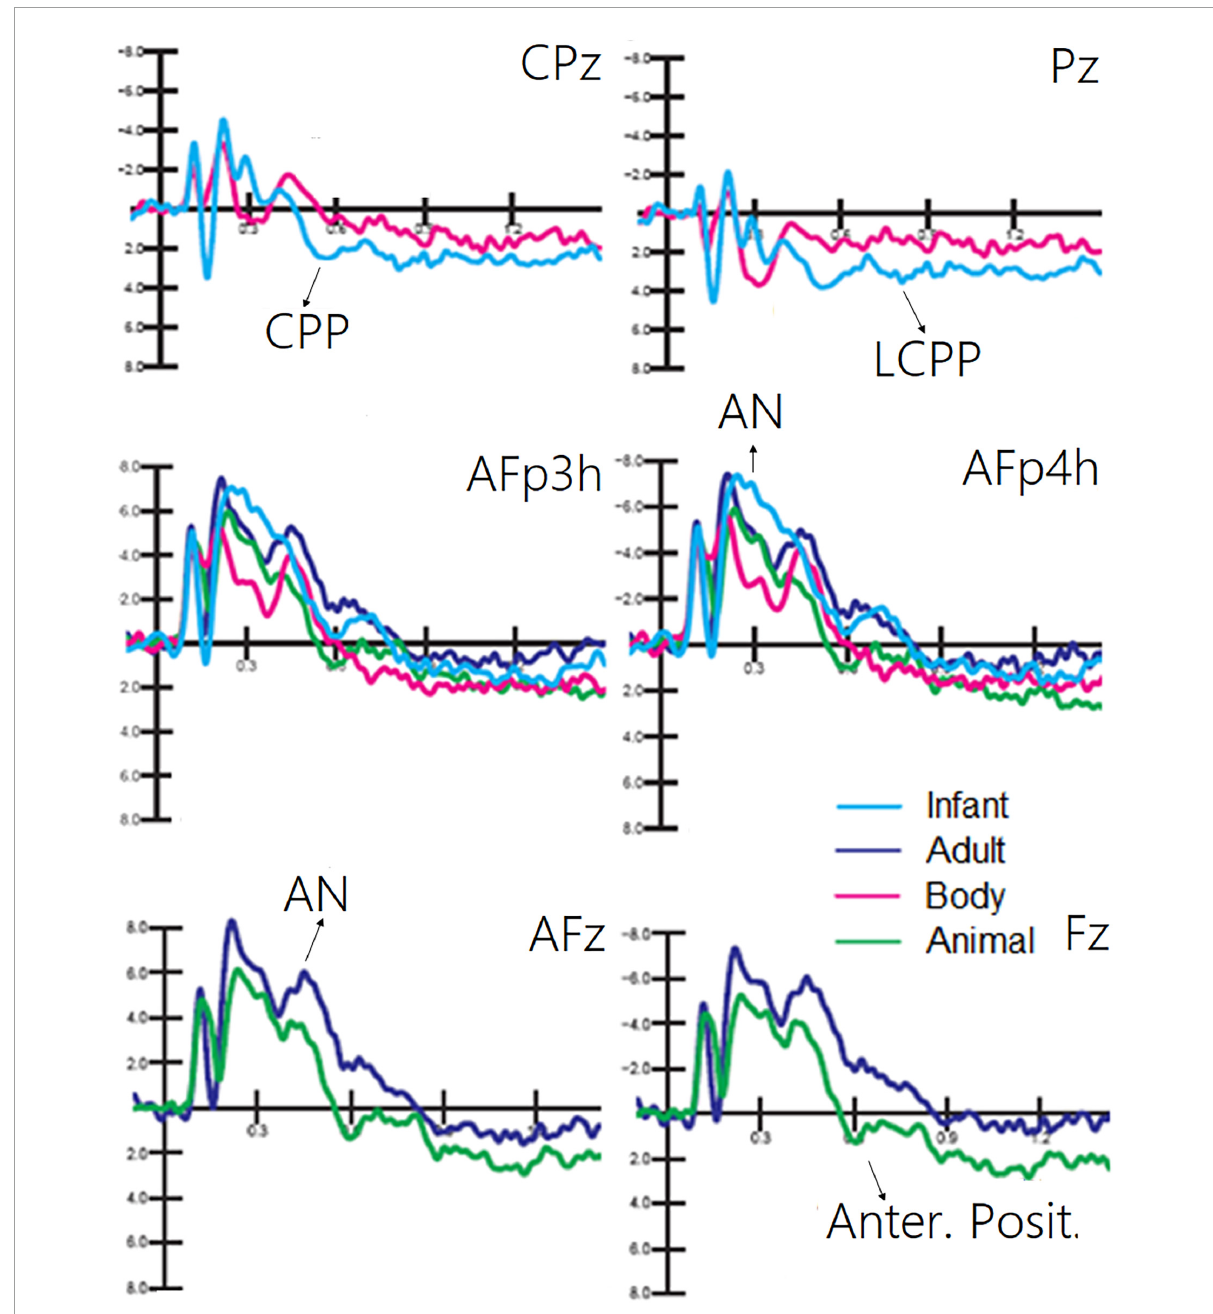
FIGURE5 Grand average ERP waveforms showing late latency ERP components sensitive to living visual